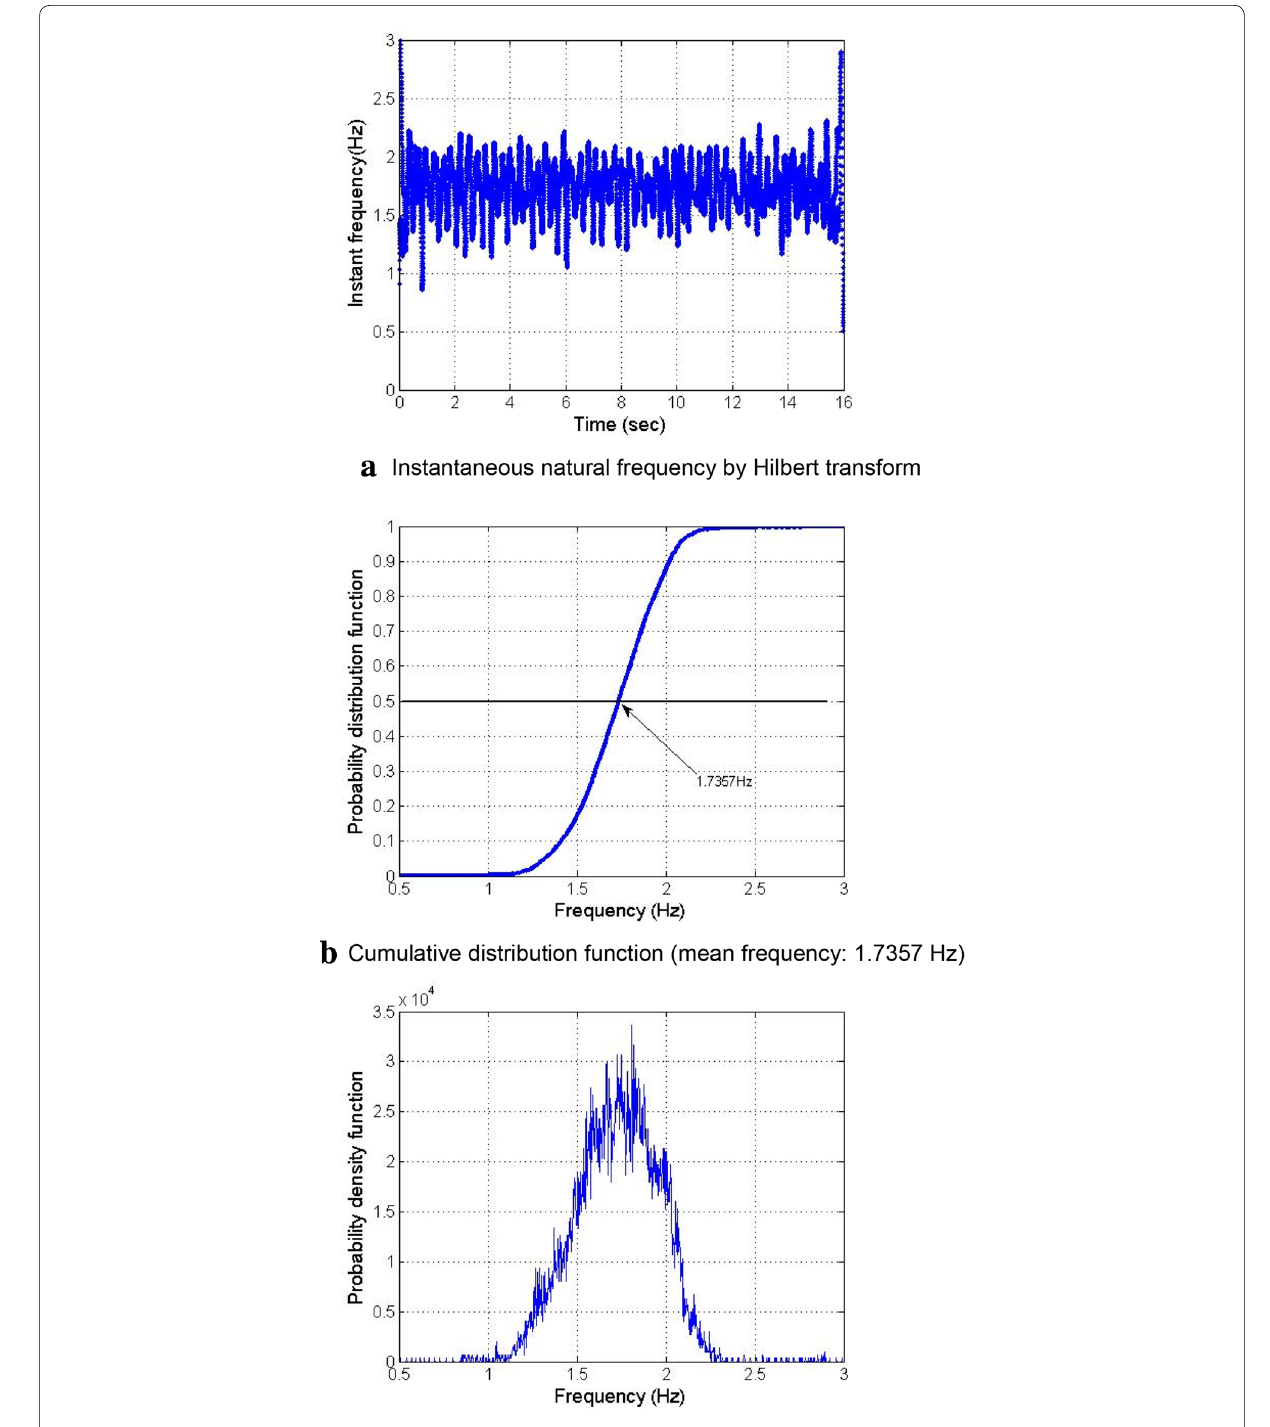
Fig. 7 The natural frequency distribution of the first